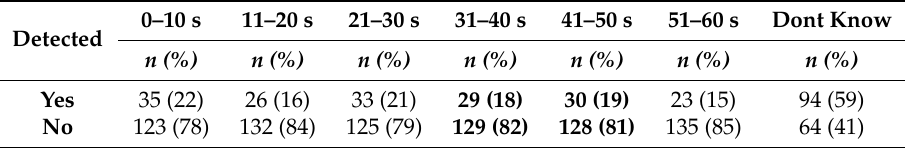
Table 3. Scenario two detection rate (dns attack).